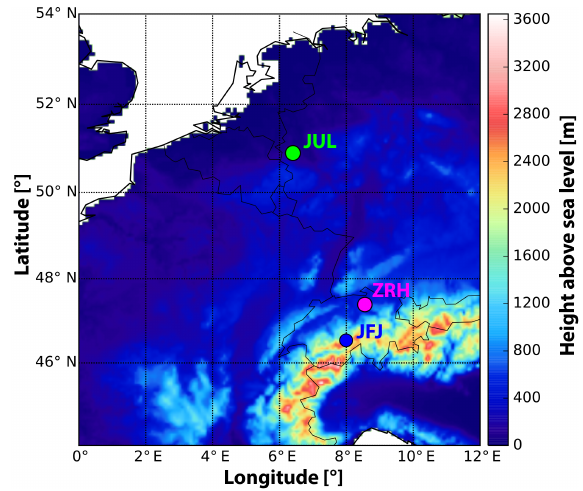
Figure 2. Location of the measurements sites Jülich (JUL), Jungfraujoch (JFJ), and Zürich (ZRH). Color-coded: topography in COSMO-7. Black lines: national borders (National Geophysical Data Center,